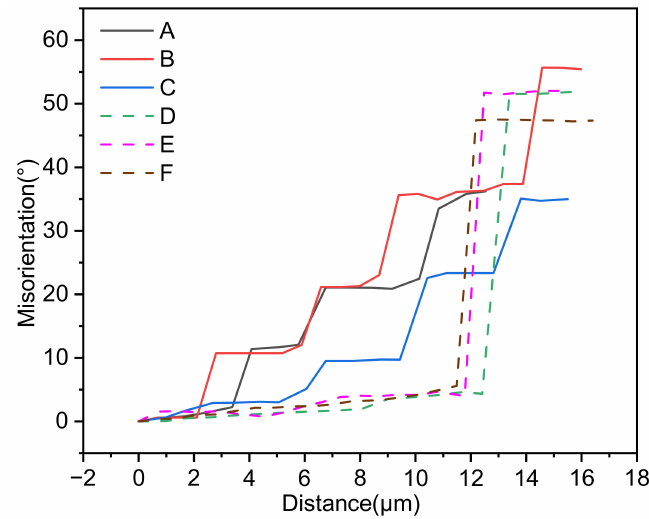
Figure 13. Cumulative misorientation along the arrows of Figure 10a.